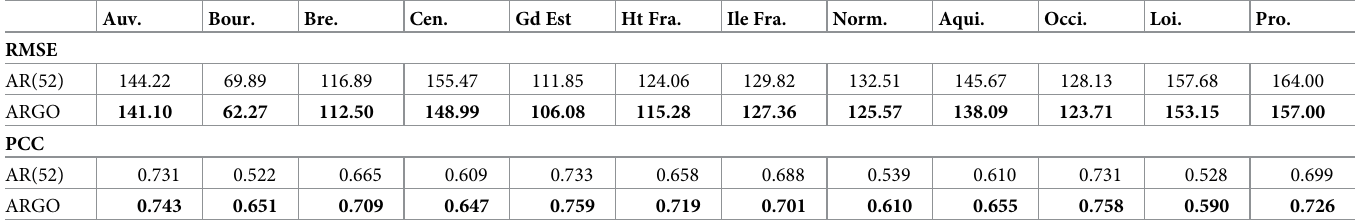
In real time (Table 7), we see that between Twitter data and AR(52) results are comparable. Twitter data lead to correlation improvements of 2% for the regions Occitanie and Pays de la Loire and decreases in error of 5% for the region Centre. For one-week ahead estimate (Table 8), estimates obtained with Twitter data are more accurate for all the regions in terms of correlation and for ten regions in terms of error metrics. Twitter data lead to correlation improvements of 10% for the region Pays de la Loire and decreases in error of 7% for the region Bretagne. For two-week ahead estimate (Table 9), results obtained with Twitter data are more accu- rate for all the regions in terms of correlation and for nine regions in terms of error metrics. Twitter data lead to correlation improvements of 20% and decreases in error of 6% for the region Bourgogne-Franche-Comte´.